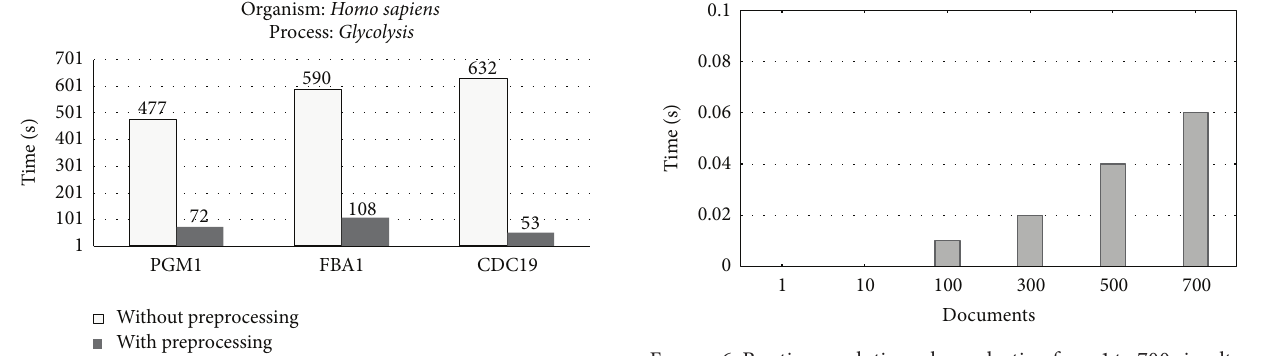
Figure 6: Runtime evolution when selecting from 1 to 700 simulta- neous documents from the Doctable